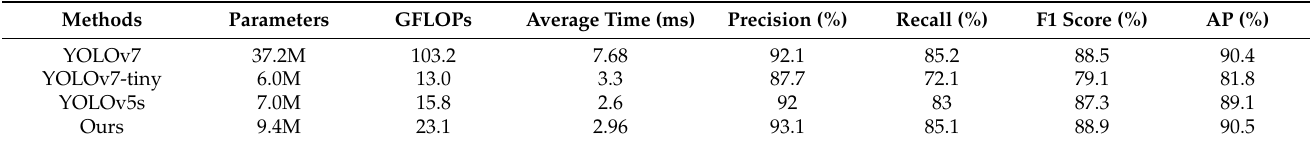
Table 3. Comparison of the results among several object detection